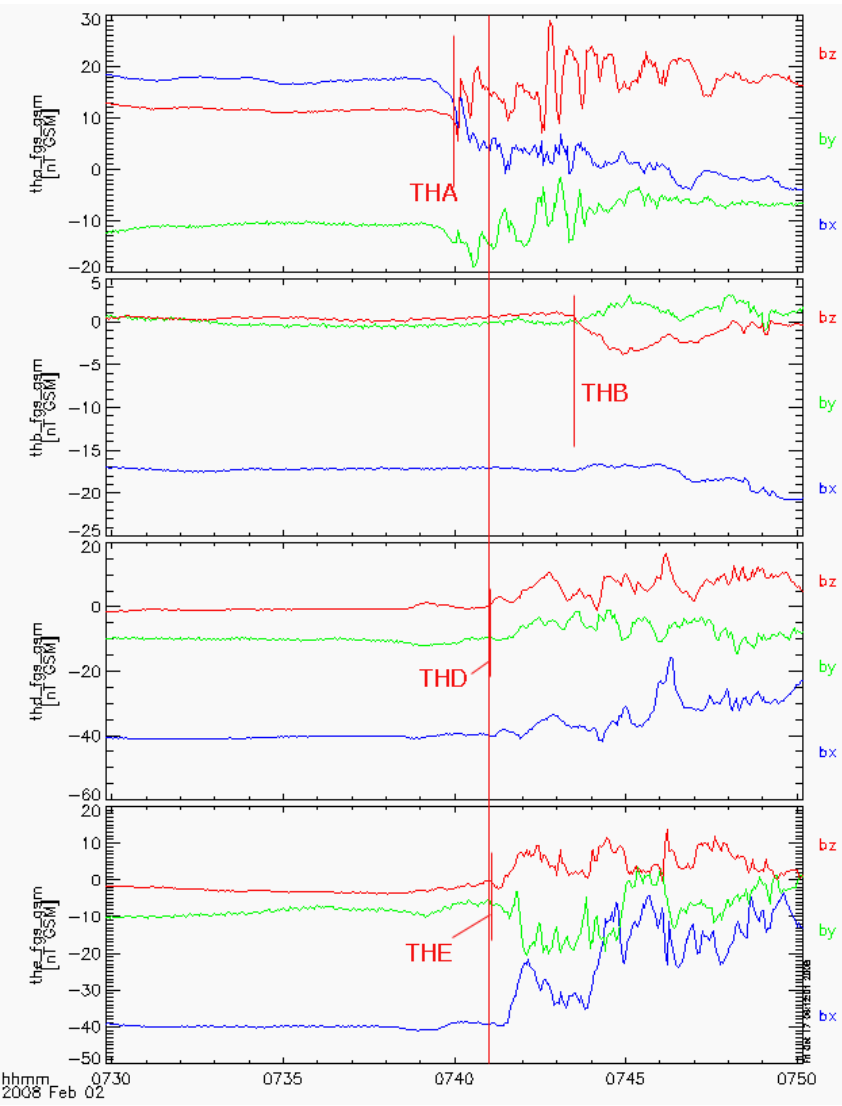
Fig. 10. THEMIS magnetometer data from THEMIS satellites A, B, D and E. The onset of the large scale intensification of the aurora as seen from the ground at 07:41UT. The sequence of observations is THA, ground, THD, THE and THB. Figure 10. THEMIS magnetometer data from THEMIS satellites A,B, D and E. The onset of 300, 500 and 800 km, respectively. These results are also of the large scale intensification of the aurora as seen from the ground at 0741 UT. The given in Table sequence of observations is THA, ground, THD, THE and THB Figure 10 shows the THEMIS satellite magnetometer signatures for the ~0740 UT event. The onset of the non-linear intensification and poleward expansion in the optical aurora is at 07:41:00 as determined from the all sky imager data Figure 7 labeled as (step) 4. It was shown with the vertical line spanning the plot. The magnetic signatures of the